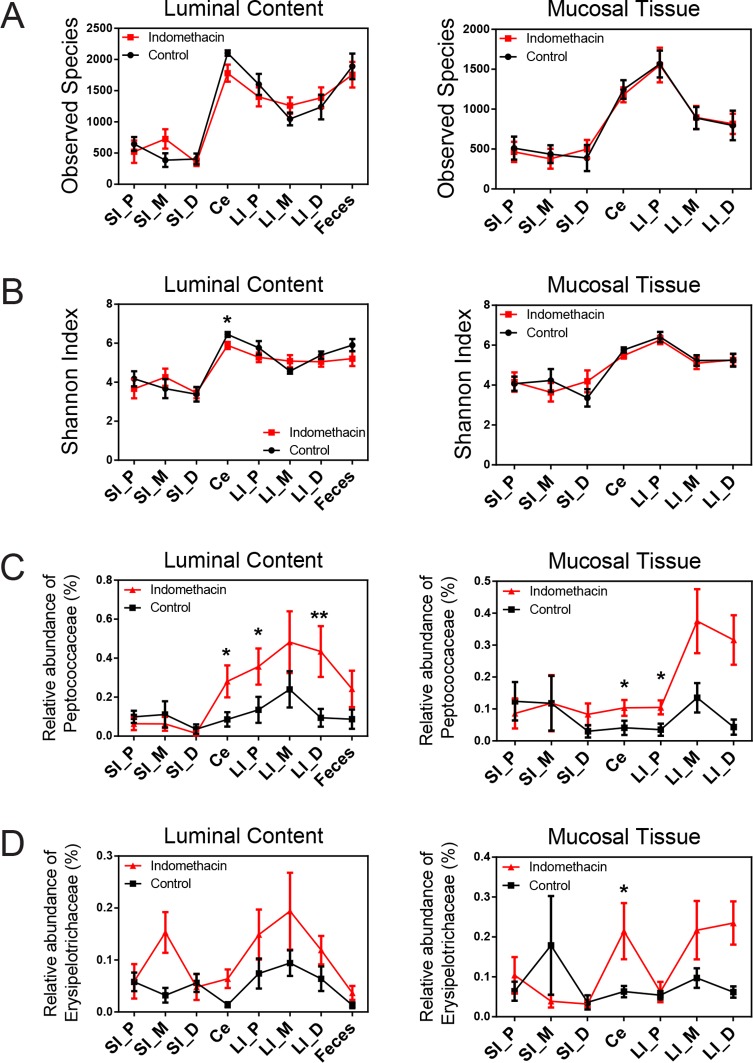
Chronic indomethacin treatment induces changes in microbial composition along the intestine in mice.Bacterial communities colonized in the mouse intestine were profiled using 16S rRNA gene sequencing and analyzed using QIIME (Caporaso et al., 2010b). Observed Species (A) and Shannon Index (B) are used to estimate richness and diversity of microbial communities in luminal content (left) and mucosal tissue (right) at anatomical sites along the intestine in indomethacin (red) and control (black) groups. Indomethacin altered microbial diversity in the cecum lumen. *p<0.05 by one-tailed Mann-Whitney test. N=9–10/group. Relative abundance of Peptococcaceae (C) and Erysipelotrichaceae (D) at anatomical sites along the intestine are significantly elevated in indomethacin (red) group than in control (black) group in both luminal content and mucosal tissues of the distal gut. *p<0.05, **p<0.01 by one-tailed Mann-Whitney test. Mean ± S.E.M. shown. SI, small intestine; Ce, cecum; LI, large intestine. P, proximal; M, middle; D, distal.